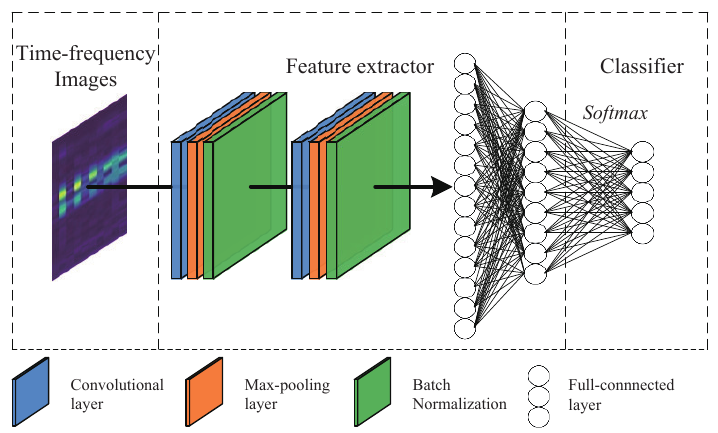
Figure 2. Feature extractor and classifier